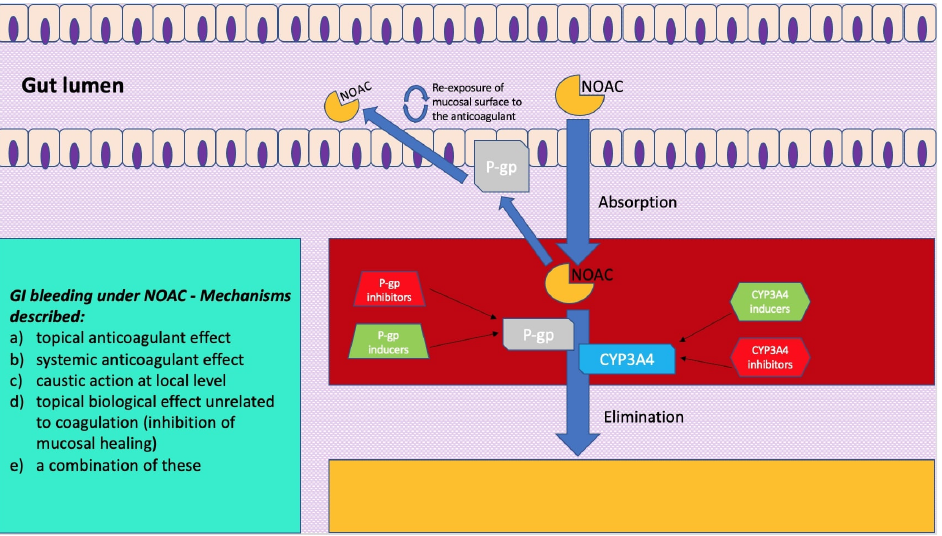
Figure 1. A simplification model of how molecular mechanisms related to pharmacokinetics of novel oral anticoagulants (NOACs) exert a clinical impact on gastrointestinal bleeding. On the left is a scheme showing mechanisms described for gastrointestinal bleeding under NOAC treatment. (P-gp)